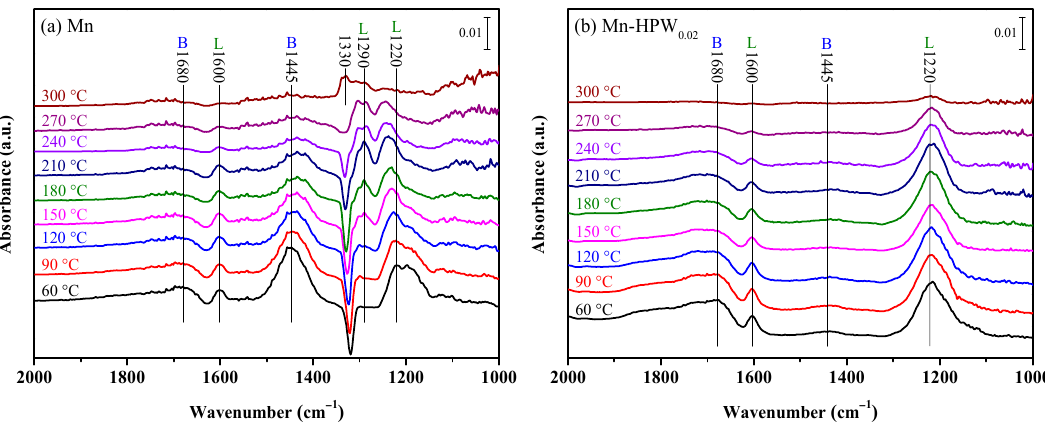
Figure 9. DRIFT spectra of NH 3 -derived species on Mn ( a ), Mn-HPW 0.02 ( b ) obtained by subtracting the corresponding background spectra. The catalysts were pretreated with 500 ppm NH 3 for 60 min and then purging by N 2 for 30 min at 30 °C.